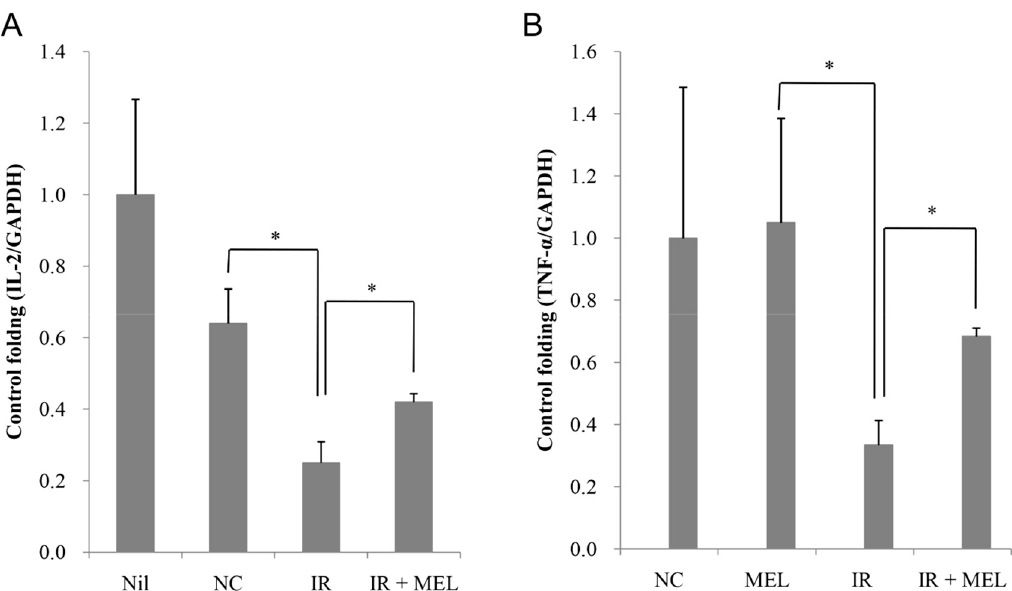
Figure 6. Expression levels of IL-2 ( A ) and TNF- α ( B ) in the spleen of mice in the NIL, NC, IR and IR + MEL treatment groups. NIL, mice with no induction of tumor or treatment; NC, mice receiving no treatment; IR, mice treated with a single dose of X-ray radiation; IR + MEL, mice treated with 40 mg/kg nanomelanin once before X-ray radiation and again 2 days post-radiation. *: Significant difference with P < 0.05 from the control by the Student’s t-test.